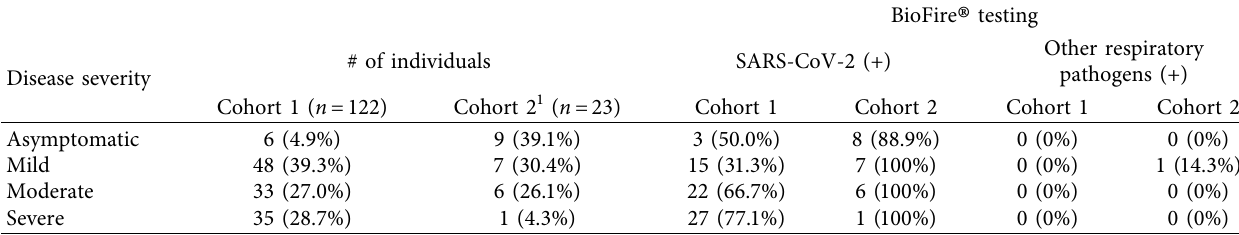
Table 2: COVID-19 severity and concurrent respiratory